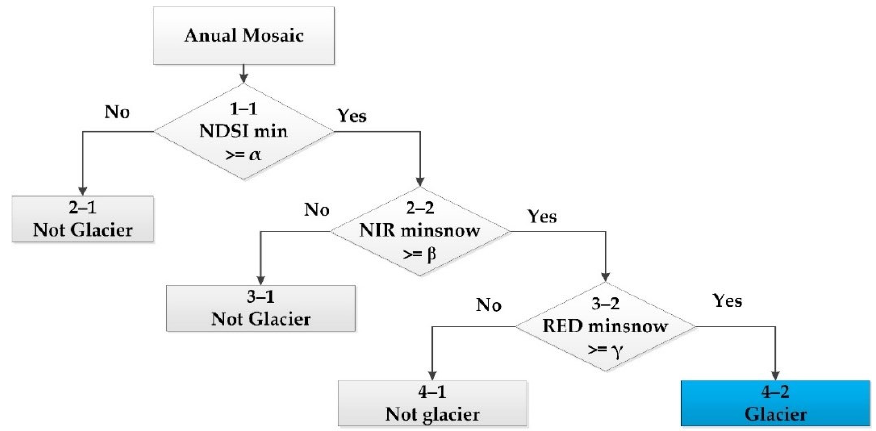
Figure 5. Empirical decision tree used for the classification of the TAGs.